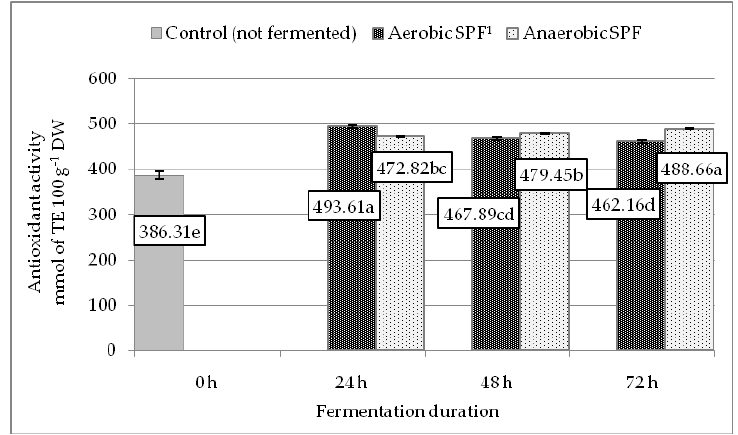
Figure 1. Theinfluence of SPF on the antioxidant activity of organic willowherb leaves ( p < 0.0001). Means followed by the same letter are not significantly different ( p < 0.05), n = 3. 1 SPF—solid-phase fermentation.